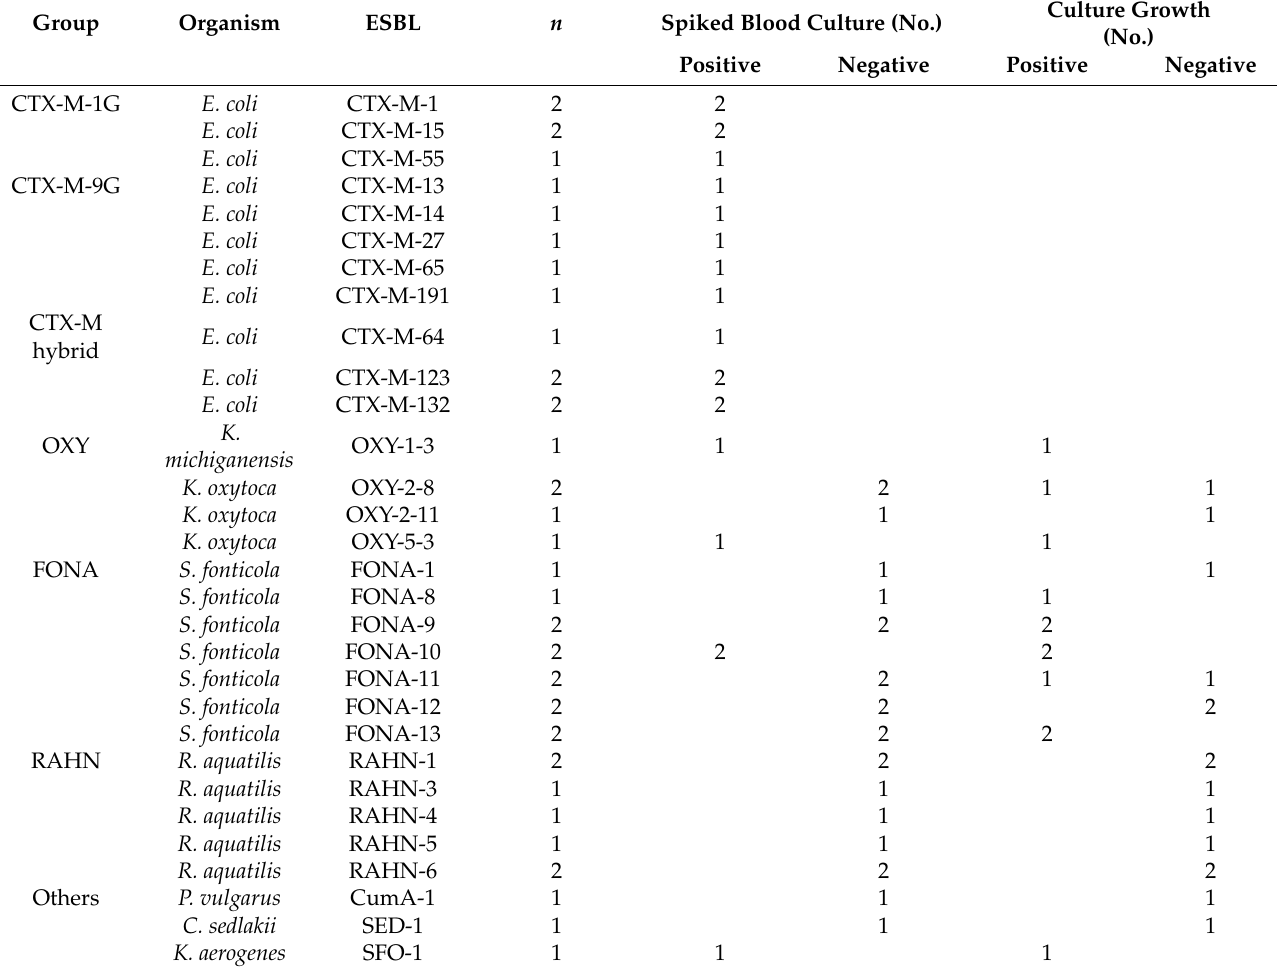
Table 1. CTX-M MULTI results of reference isolates from spike blood cultures and culture growth.